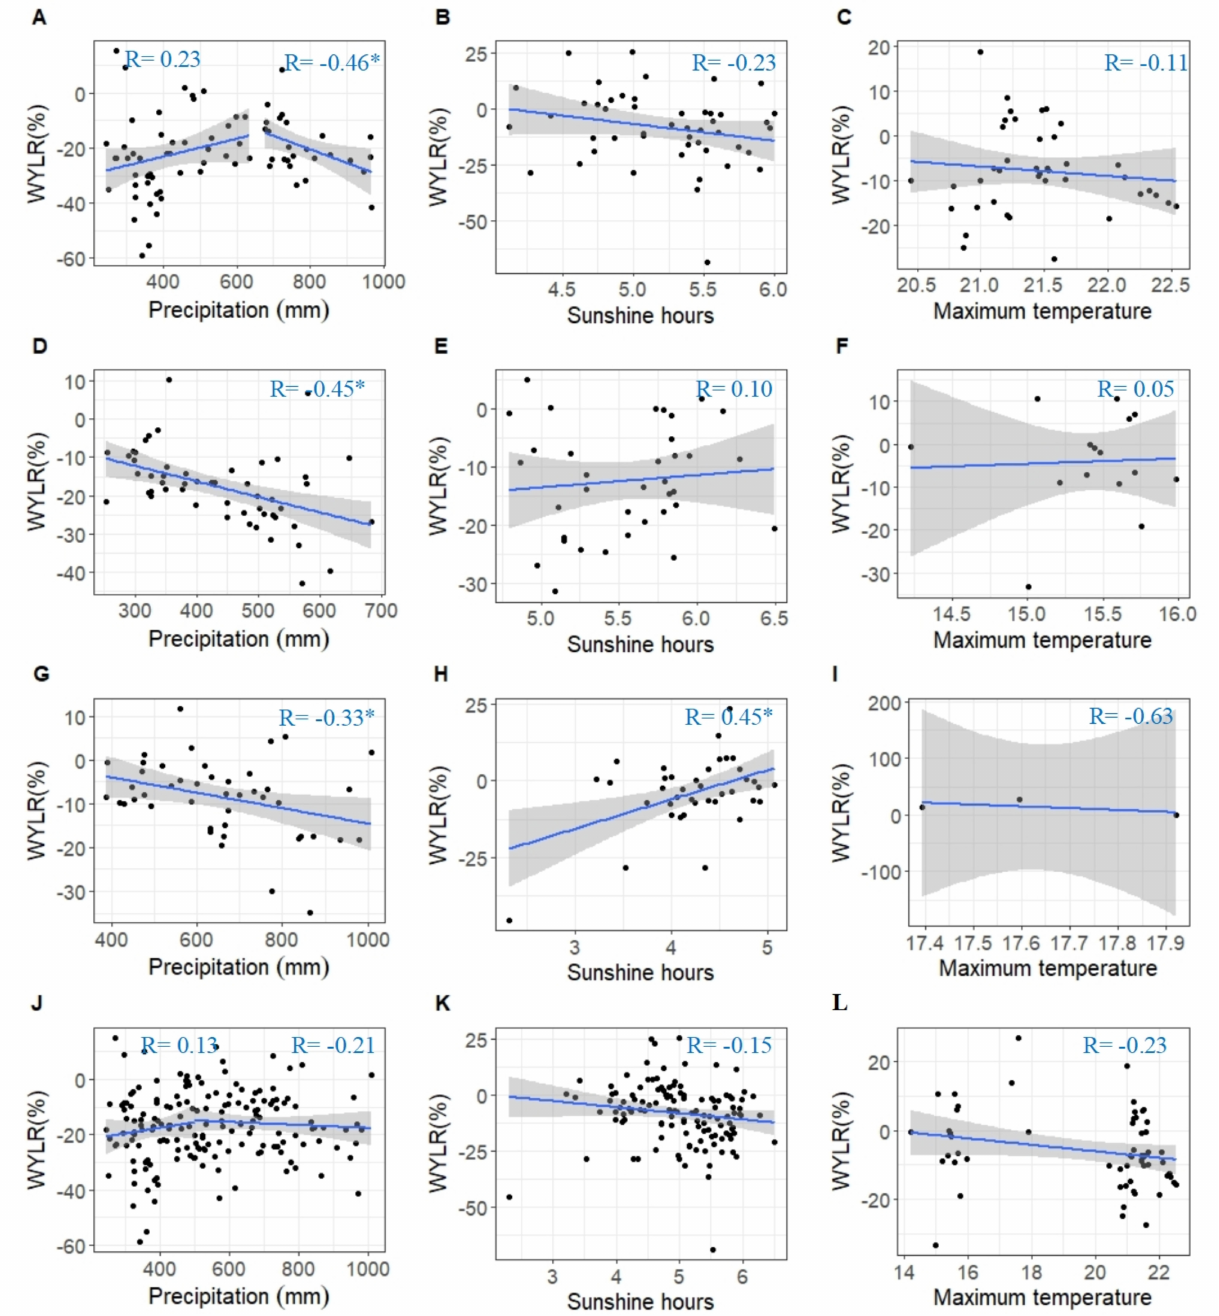
Figure 7. The relationship between WYLR in extreme wet years and the three mean climate factors in Anhui ( A – C ), Jiangsu ( D – F ), Hubei ( G – I ) and whole study area ( J – L ). Note: each point represents one station (county) samples that has the extreme conditions of total precipitation, mean sunshine hours, mean maximum temperature and the gray area is the 95% confidence interval of fitted model, and the blue line in the figure represents the linear fitted line. The asterisk (*) indicates that the correlation between them has passed the significance